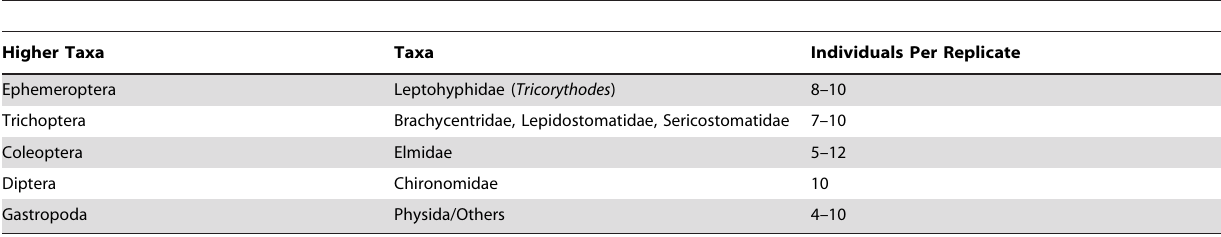
Table 2. Higher taxa (i.e. Class/Order), lower taxon (i.e. Family/Genus), and individuals per